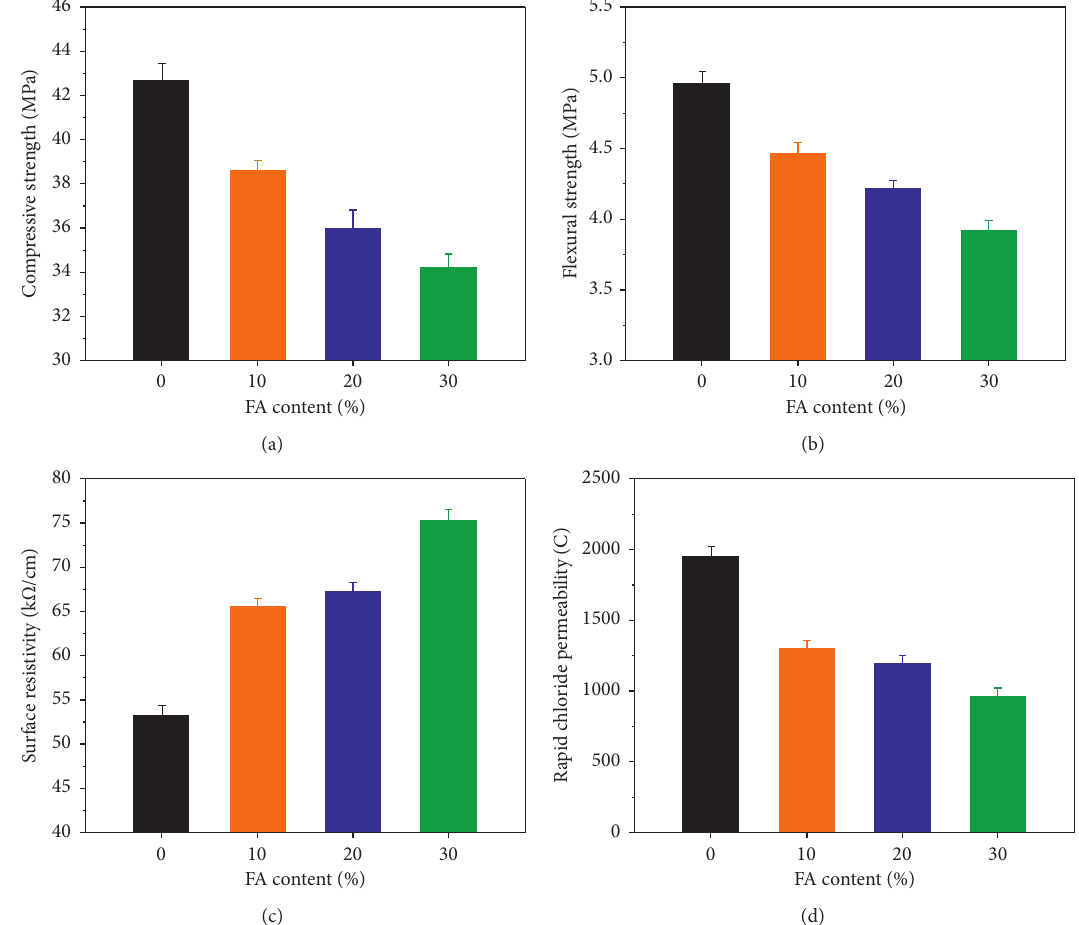
Figure 5: Influence of single-mineral admixture-FA on the performances of concrete. (a) Compressive strength. (b) Flexural strength. (c) Surface resistivity. (d) Rapid chloride